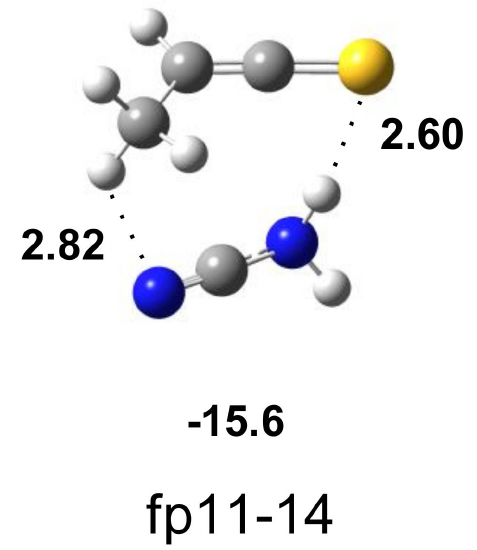
Figure 7. B3LYP/6-311++G(3df,3pd) optimized structure of the H 2 N–C ≡ N ··· S=C=C(H)CH 3